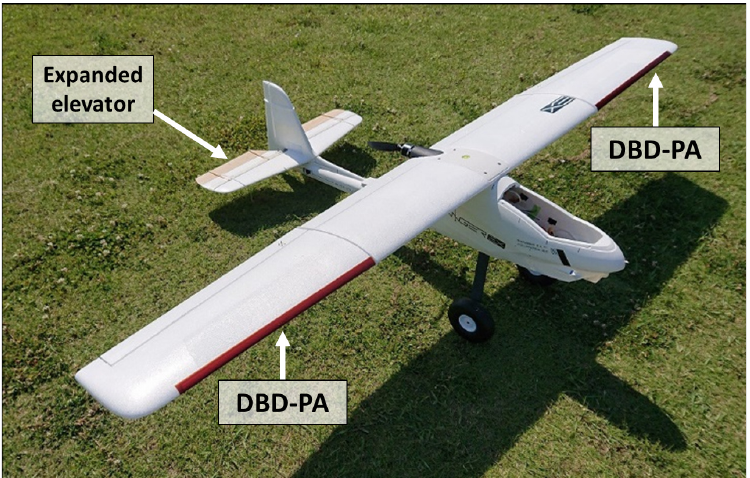
Figure 3. Voltantex RC Ranger EX. Plasma actuators were attached to both main wings; notably, the front cover is removed in this